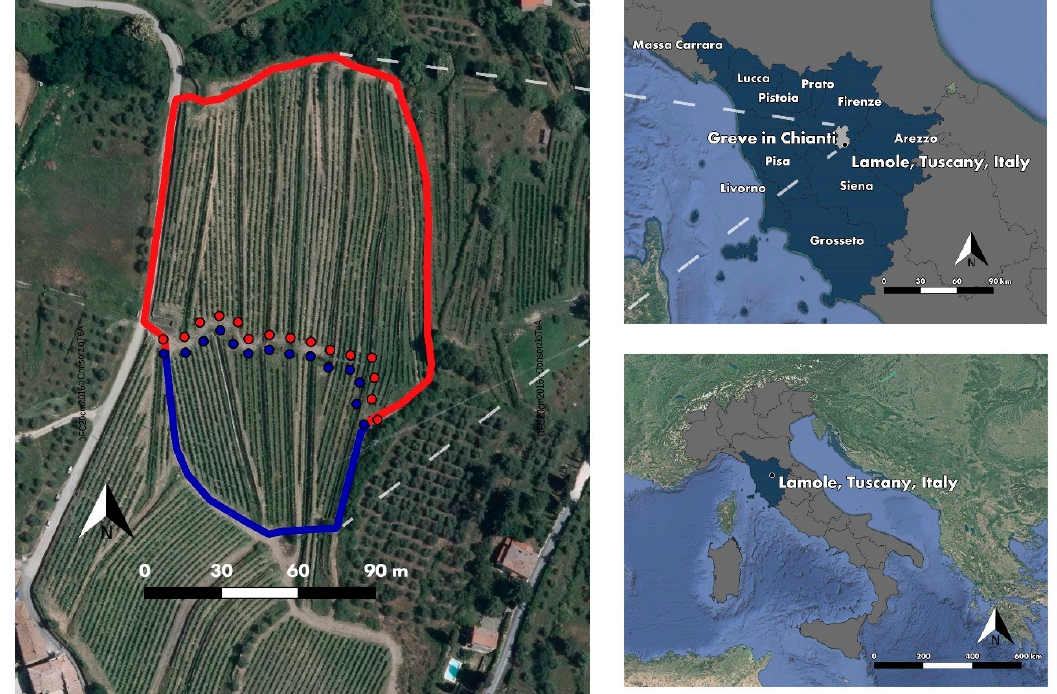
Figure 2. Location of the study area. Red border – North area; blue border – South area of the Grospoli vineyard in Tuscany region (Italy).